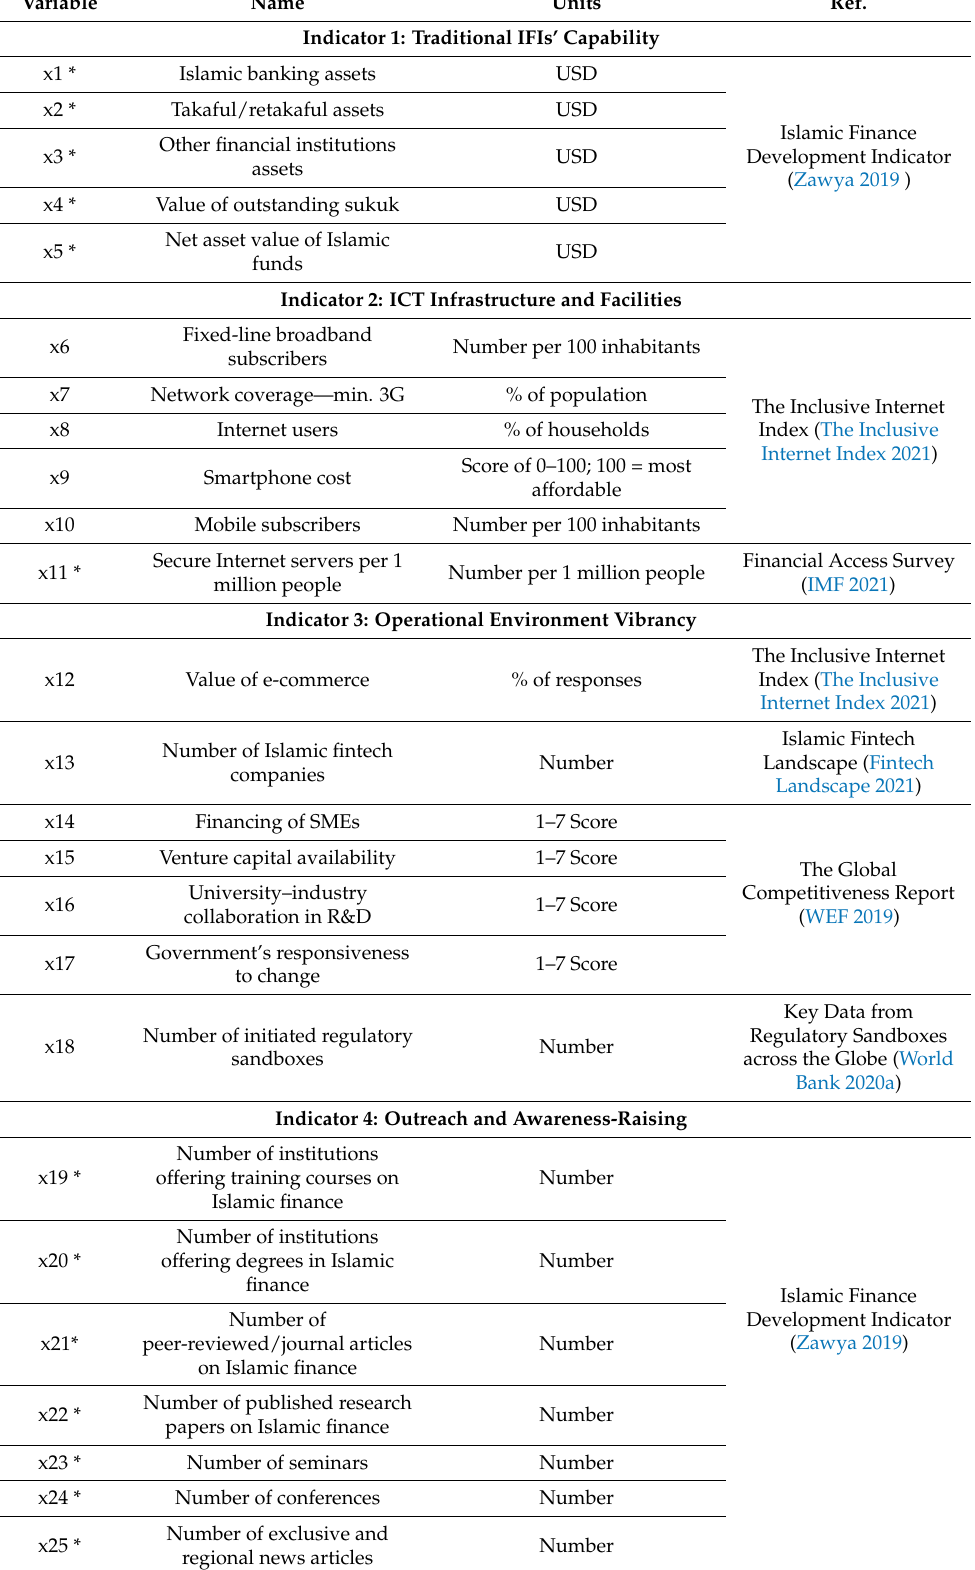
Table 1. Measurement units and data sources of chosen